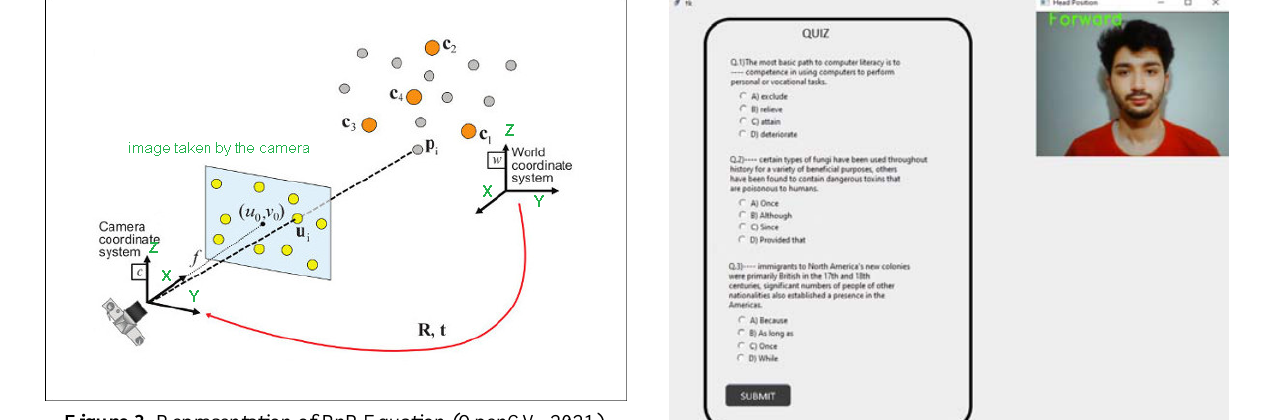
Figure 3 . Representation of PnP Equation (OpenCV, 2021).